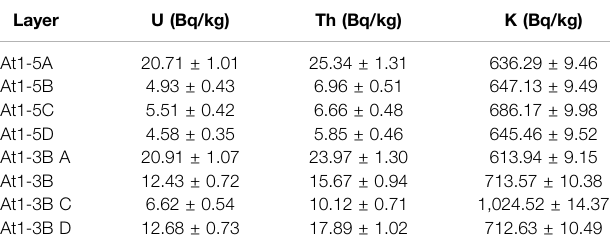
TABLE 2 | Summary of the dose rate data shown for the individual stratigraphic layers of At trench 5 and trench 3B. Layer U (Bq/kg)